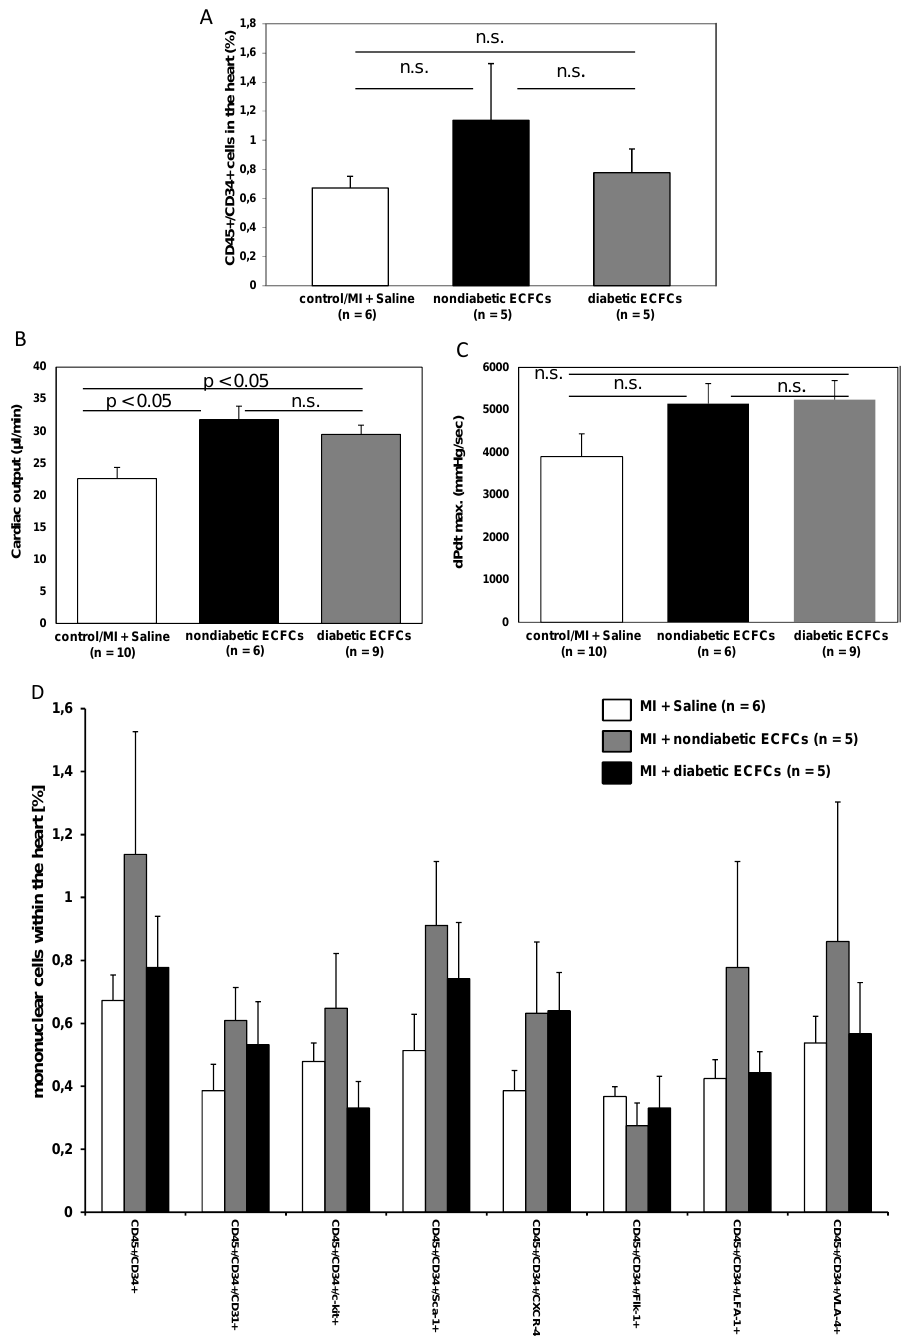
Figure 6. No difference in therapeutic effectiveness of ECFCs derived from diabetic or nondiabetic donors after transplantation into ischemic myocardium. ( A ) Bar graphs representing the percentage of CD45 + /CD34 + stem cells in the ischemic hearts of control animals (white bar) after ECFC transplantation from nondiabetic donors (black bar) and after ECFC transplantation from diabetic donors (grey bar) 2 days after MI. Data represent mean ± SEM; n.s., not significant. ( B ) Bar graphs representing cardiac output and contractility ( C ) of control animals (white bar) after ECFC transplantation from nondiabetic donors (black bars) and after ECFC transplantation from diabetic donors (grey bars) 30 days after MI. Data represent mean ± SEM; n.s., not significant. ( D ) Bar graphs representing the percentage of CD45 + / CD34 + subpopulations in the ischemic hearts of control animals (white bar) after ECFC transplantation from nondiabetic donors (black bars) and after ECFC transplantation from diabetic donors (grey bars) 2 days after MI. Data represent mean ± SEM; n.s., not